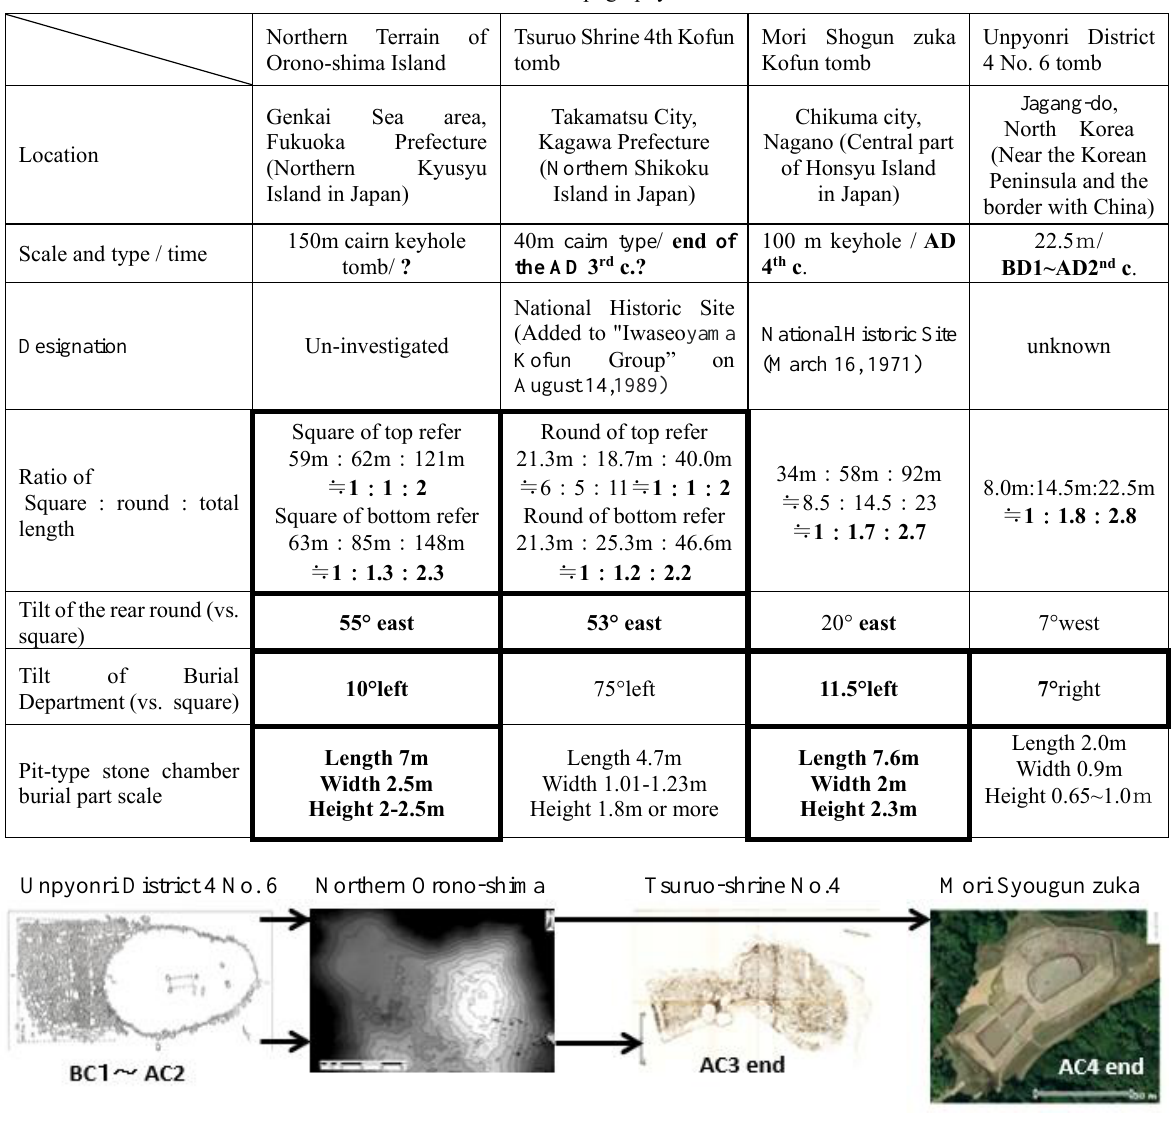
Similarities between the northern topography of Orono-Island and the three tombs.